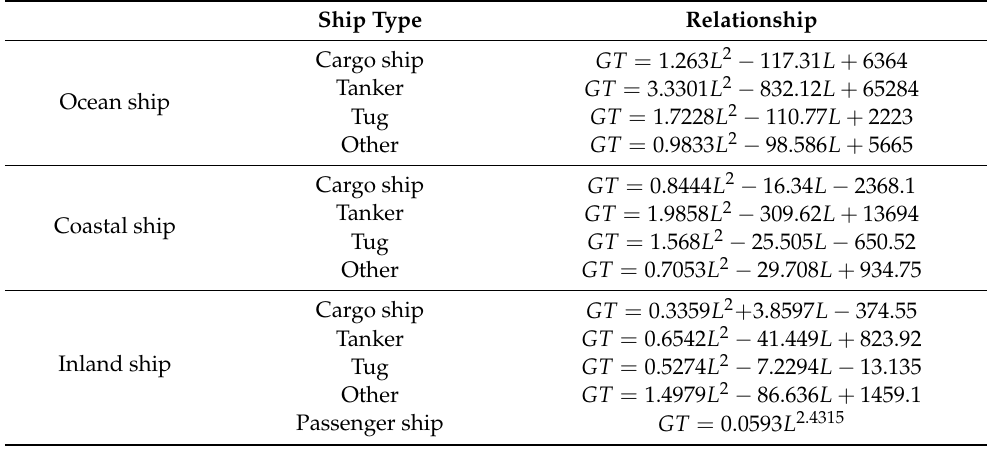
Table 4. Relationship between length and GT.